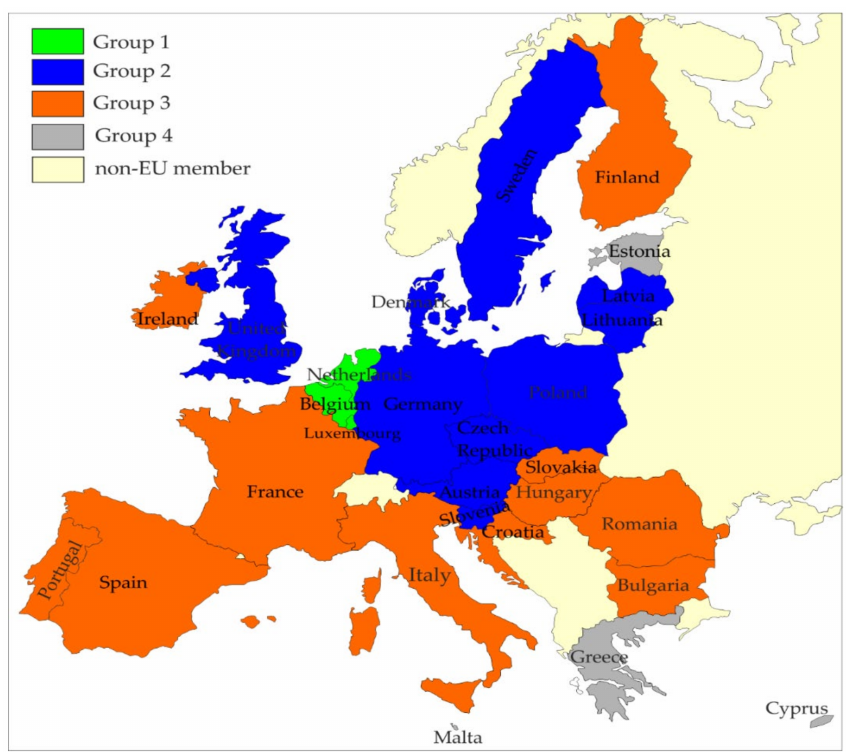
Figure 3. EU countries CE classification